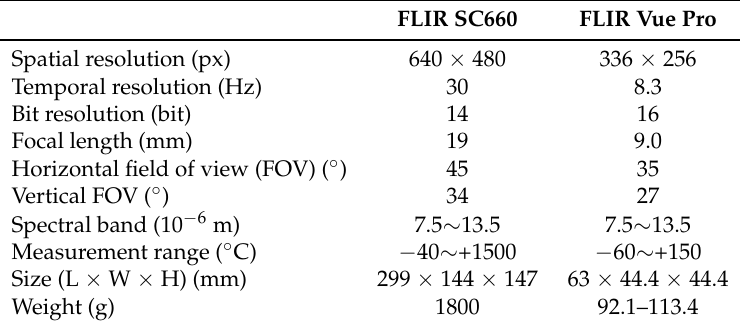
Table 1. Summary of the specifications of the thermal